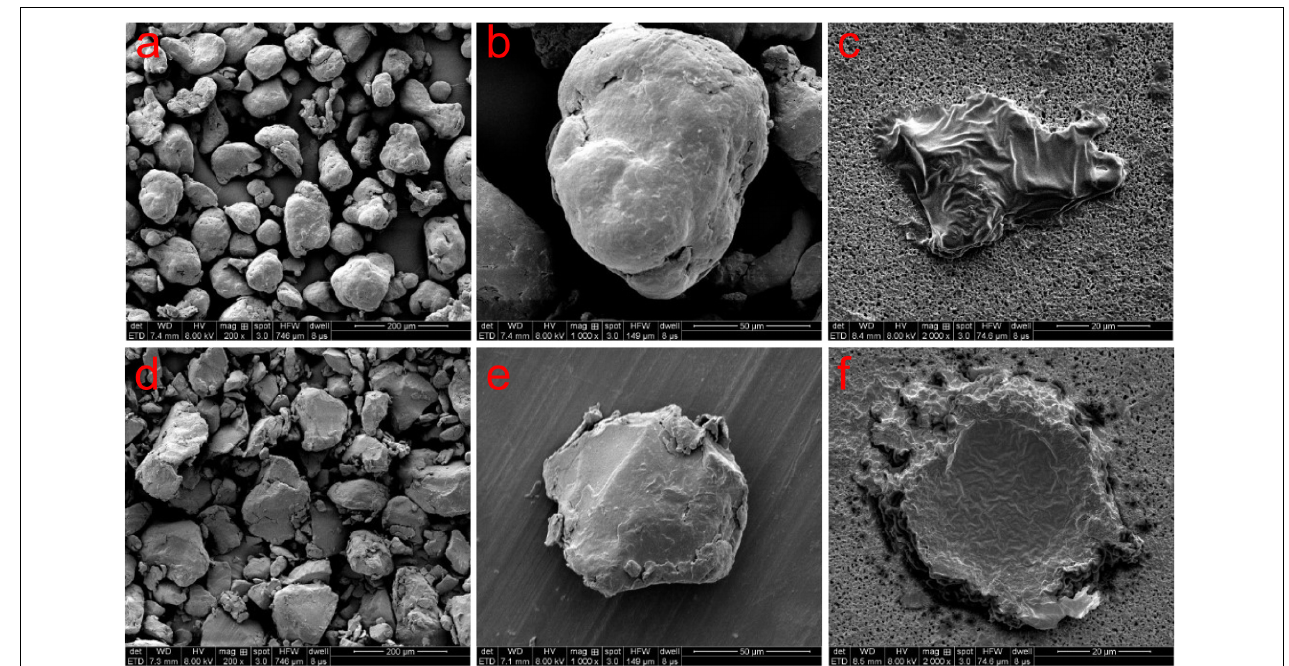
FIGURE 3 | SEM images of pristine PE MPs (a,b) , extracted PE MPs (c) , pristine PS MPs (d,e) , and extracted PS MPs (f)